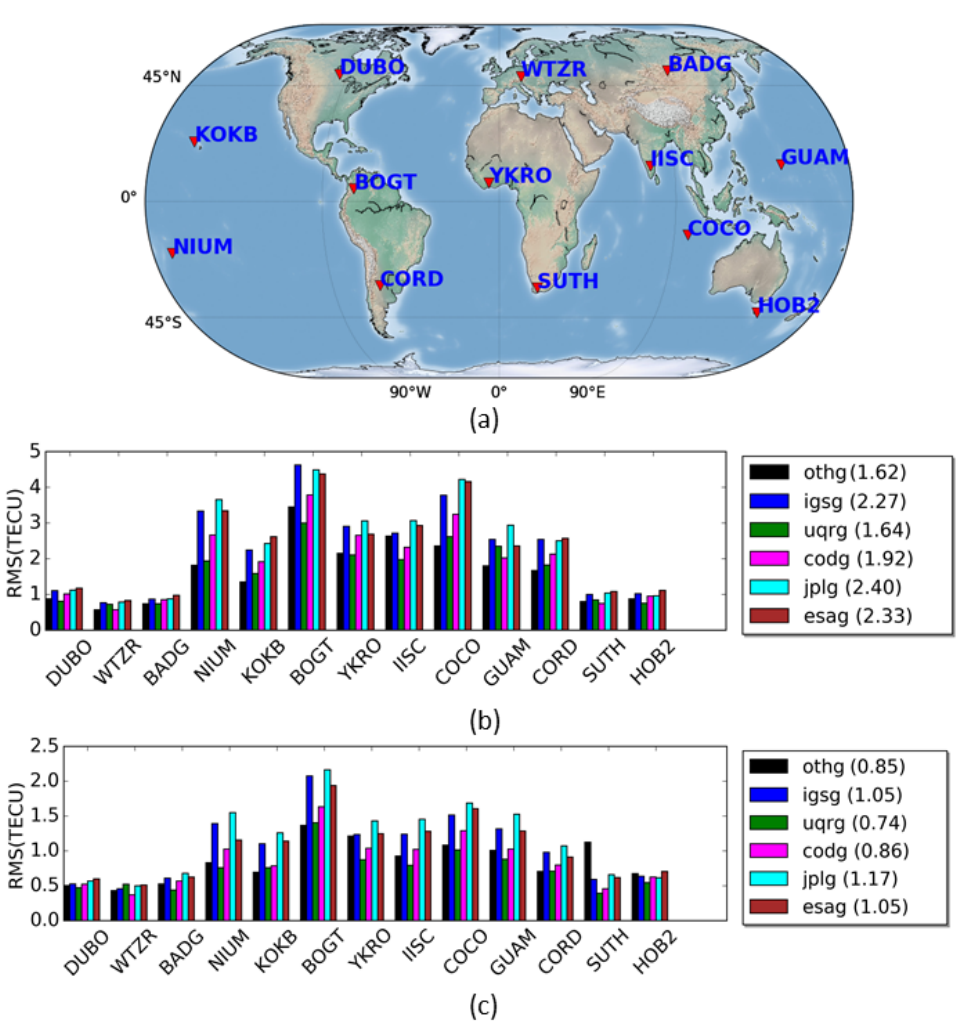
Figure 4. RMS values from the dSTEC analysis at the GNSS stations depicted in panel ( a ). The results refer to the data sets covering the days between ( b ) DOY 41 and DOY 110 of year 2015 and ( c ) DOY 222 and DOY 293 of year 2017. The label “othg” stands for the presented